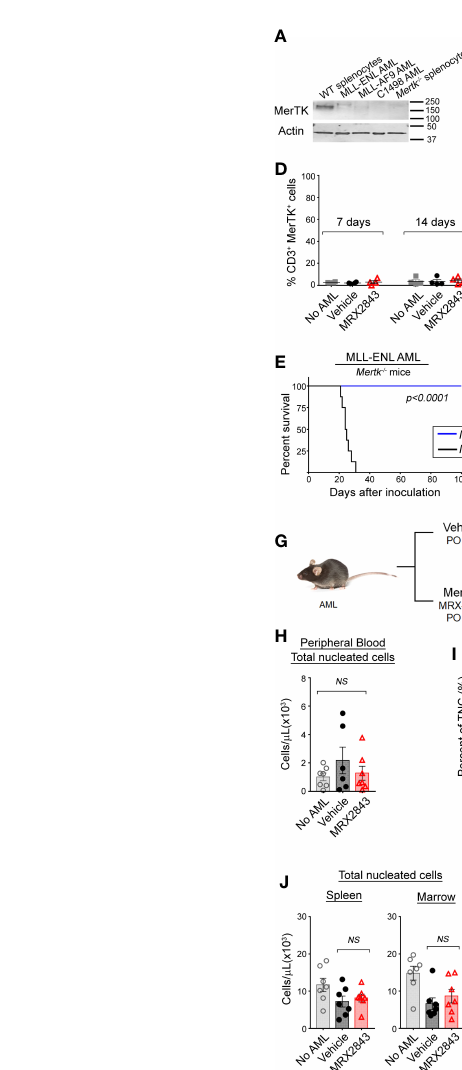
alteration of the leukemia microenvironment, rather than attributable to direct cell intrinsic effects on T cells. To further validate that this survival advantage could be attributable to MerTK inhibition on macrophages in the leukemia